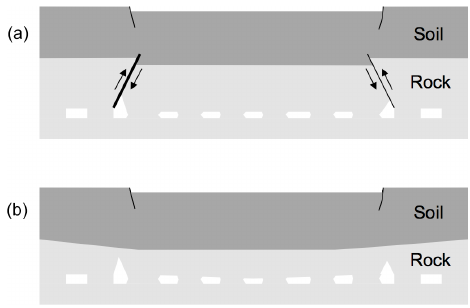
Figure 1. The two main types of large-scale pillar collapse in the limestone mines: downward movement of the rock overburden along collapse-induced faults (a) and by mere deflection of the rock overburden (b)